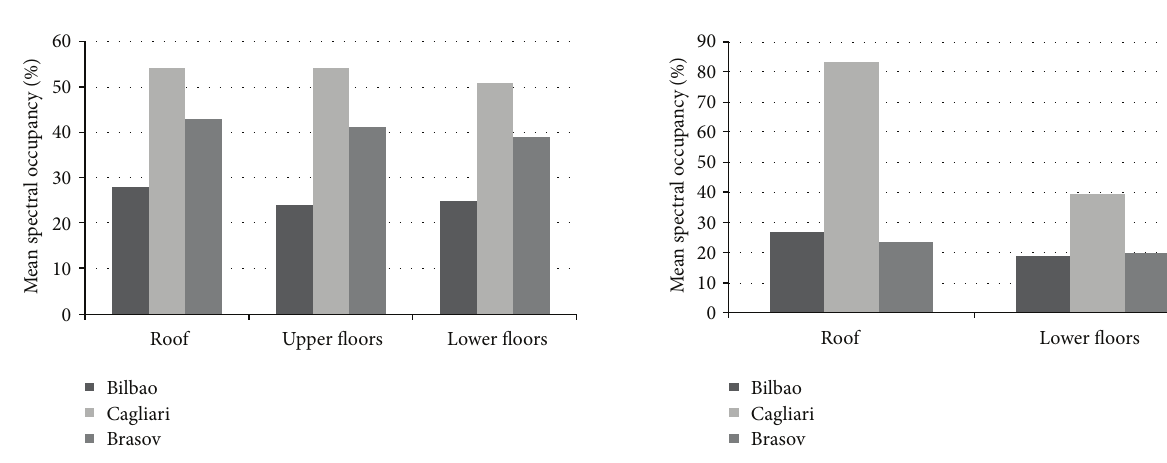
Figure 3: Mean spectral occupancy for the three cities in urban environment.